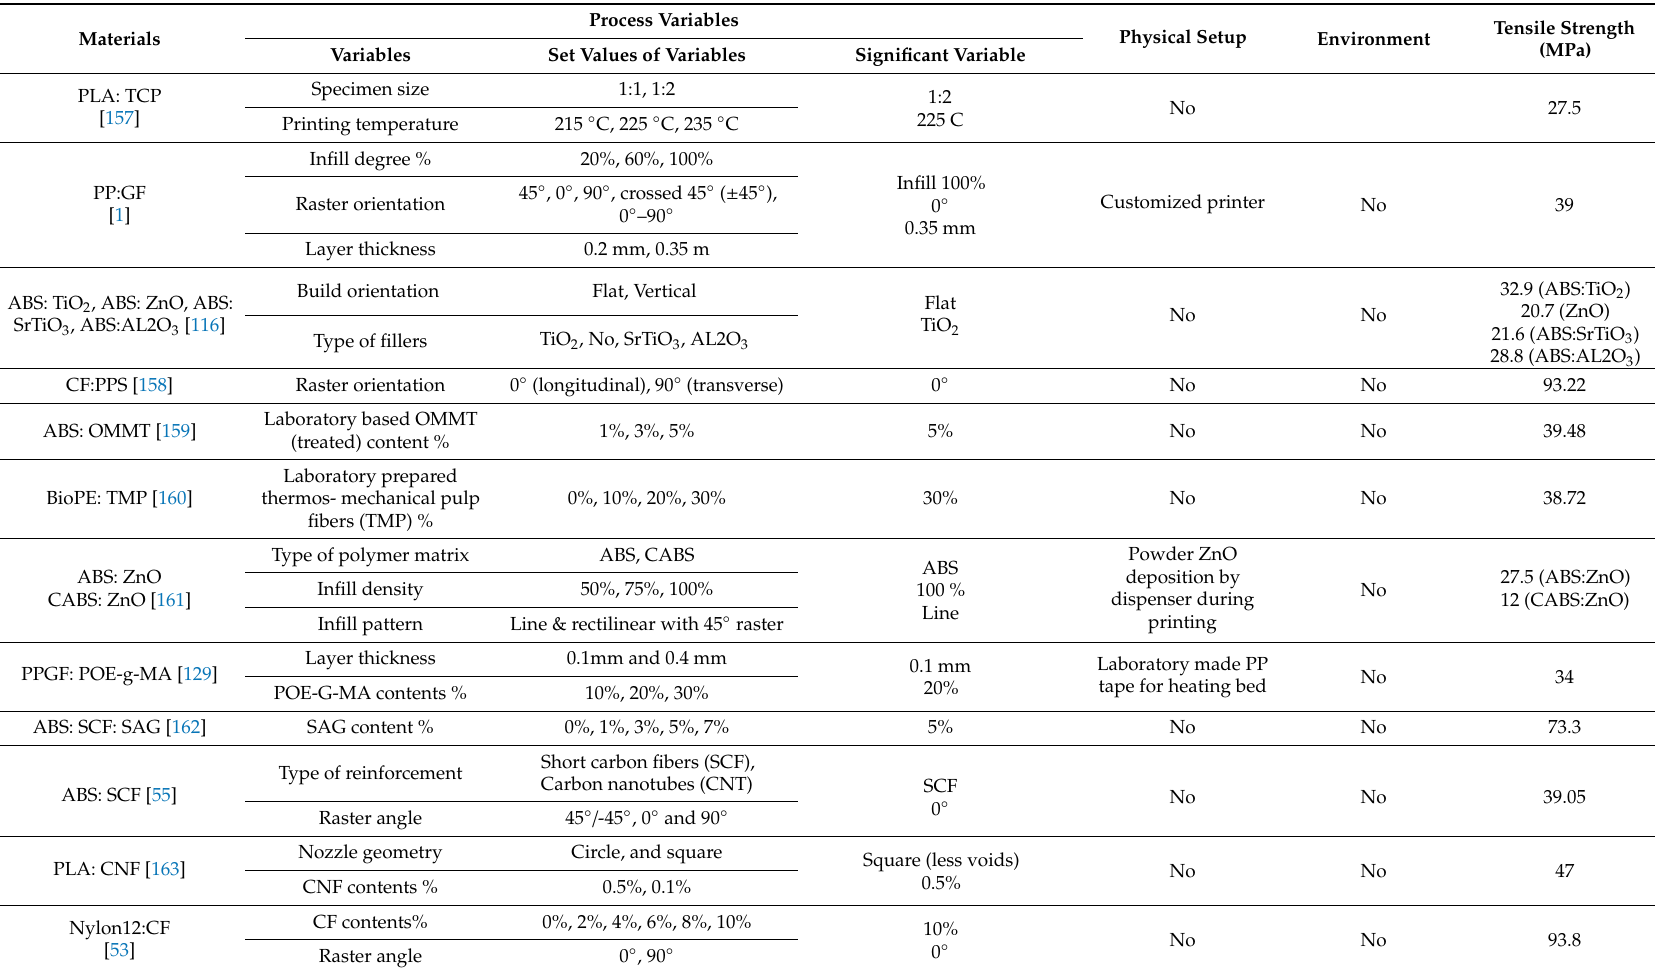
Table 4. Process factors for achieving high tensile strength for discontinuous synthetic reinforced